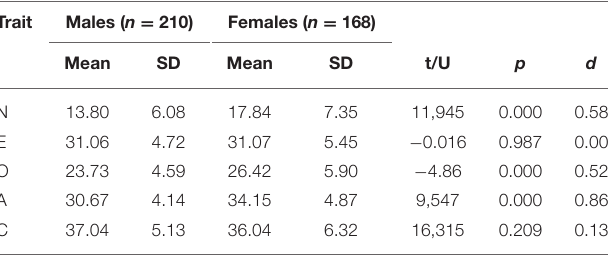
TABLE 8 | Gender differences in NEO-FFI traits ( n = 378, raw